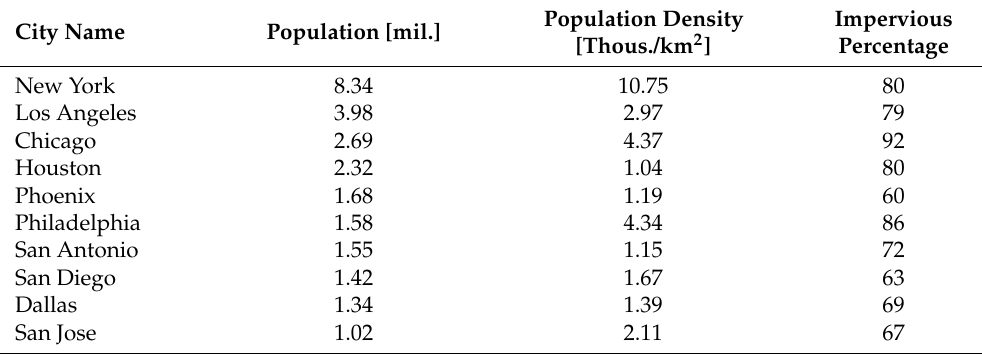
Table 1. Characteristics of the ten most populous cities in the United States. Population is taken from the Census Bureau’s 2019 estimate and population density is based on city areas derived from the Center for Disease Control’s 500 cities project